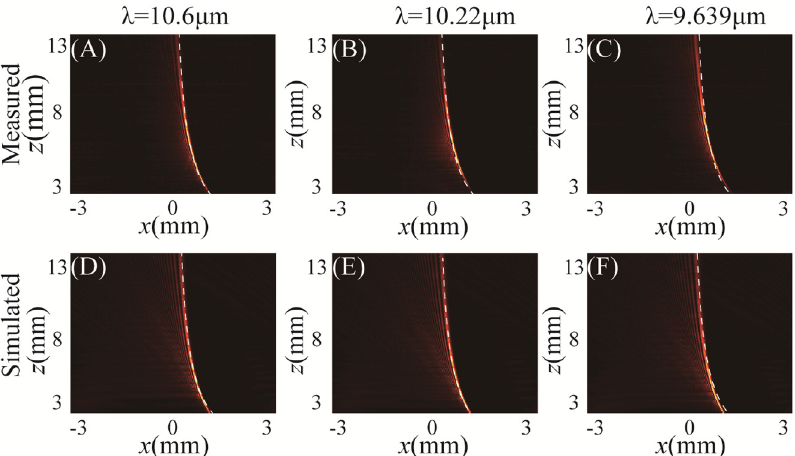
Figure 4: (A – C) Measured and (D – F) simulated self-accelerating trajectories on the x-z plane at three wavelengths under LCP